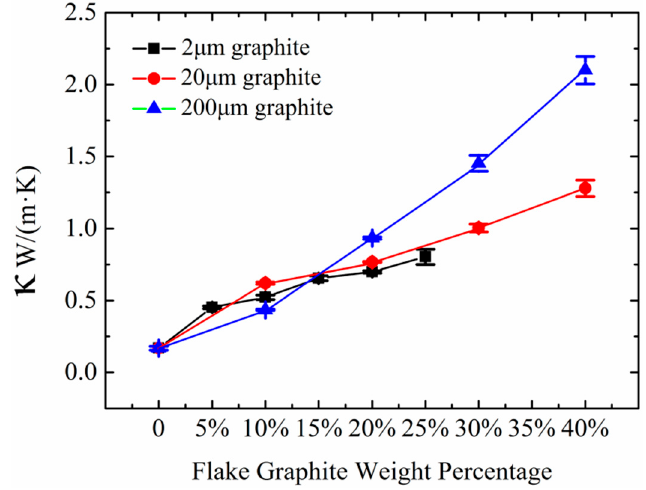
Figure 3. Thermal conductivities of the HDPE/FG composites versus FG weight percentage.